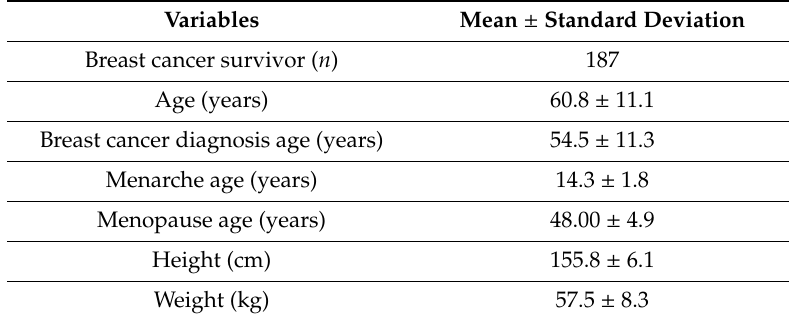
Table 1. The characteristics of the study